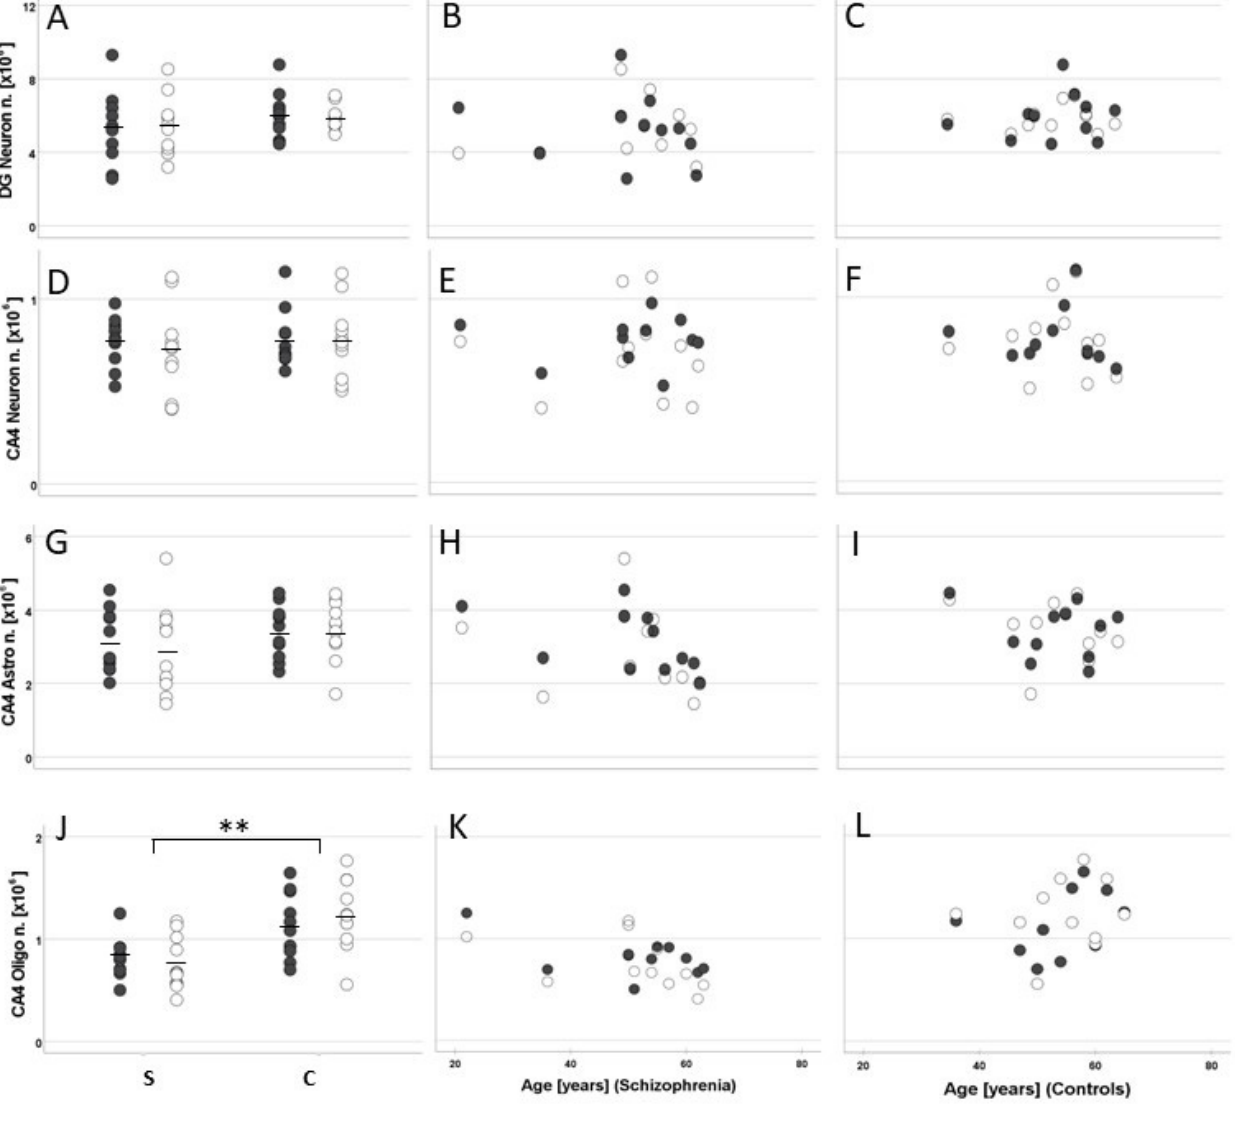
Figure 4. Mean and standard error of the mean ( A , D , G , J ) and individual values correlated with age (patients with schizophrenia [S]: ( B , E , H , K ); controls [C]: ( C , F , I , L ) of the total number of neurons in the hippocampal granule cell layer (the dentate gyrus; DG Neuron n.; ( A – C )) and cornu ammonis 4 (CA4 Neuron n.; ( D – F )) and of the number of astrocytes (CA4 Astro n.; ( G – I )), and oligodendrocytes (CA4 Oligo n.; ( J – L )) in postmortem brains from men with schizophrenia and age- and sex-matched controls. Closed dots represent data from left hemispheres, and open dots, data from right hemispheres. ** p < 0.005.